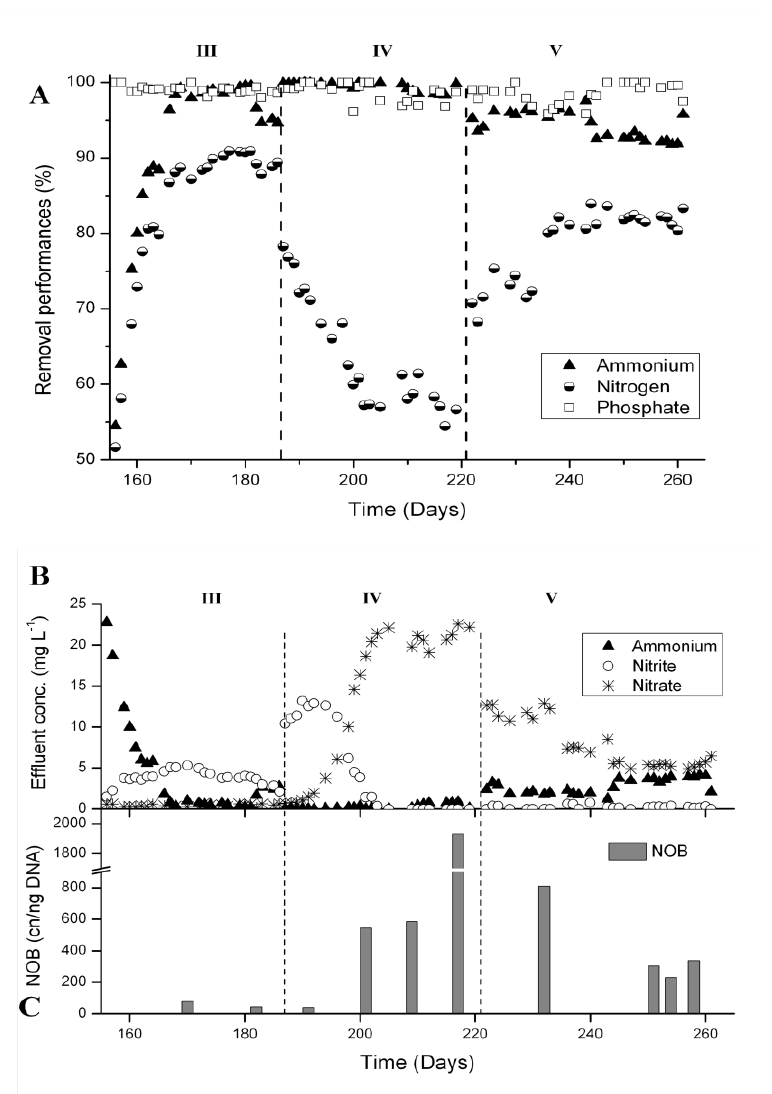
Figure 7. Nutrient removal performances at 15 °C (reactor B) from days 156 to